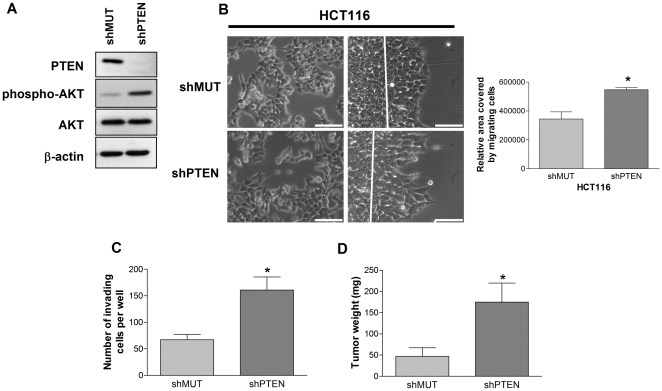
PTEN down-regulation in HCT116 increases migration/invasion capacity and tumorigenic potential.
A. HCT116 cells were infected either with recombinant lentiviruses encoding shMUT or shPTEN. After selection of infected cells, proliferating cells were lysed and protein expression was analyzed by Western blot. B. Left panels: Cell morphology was analyzed by phase contrast microscopy at subconfluence. Right panels: Newly confluent cells were wounded and treated with 2 mM hydroxyurea. After 48 h, movement of the coherent sheet across the linear wound margin (white line) was evaluated by phase contrast microscopy. The graph on the right illustrates the relative area covered by migrating cells as evaluated on 5 different wound experiments per condition using Image J software. Scale bars  = 100 µm. C. Invasion of cells was studied using Matrigel-coated Transwells. After 48 h, invading cells were fixed, stained with crystal violet 1% and counted. D. 2×106 proliferating HCT116 cells expressing shMUT or shPTEN were injected subcutaneously in 5 nude mice per condition. Tumor weight was evaluated 30 days after injection. * Significantly different at p≤0.05.